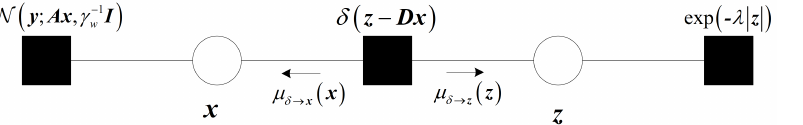
Figure 2. The figure shows the factor graph of Vector AMP for total variation regularization problems. The circles represent variable nodes and the squares represent factor nodes. µ δ → x ( x ) and µ δ → z ( z ) denote the messages from the factor node δ ( z − Dx ) to the variable nodes x and z . There are mutual messages between any two adjacent nodes in the graph. We omit some messages that are not